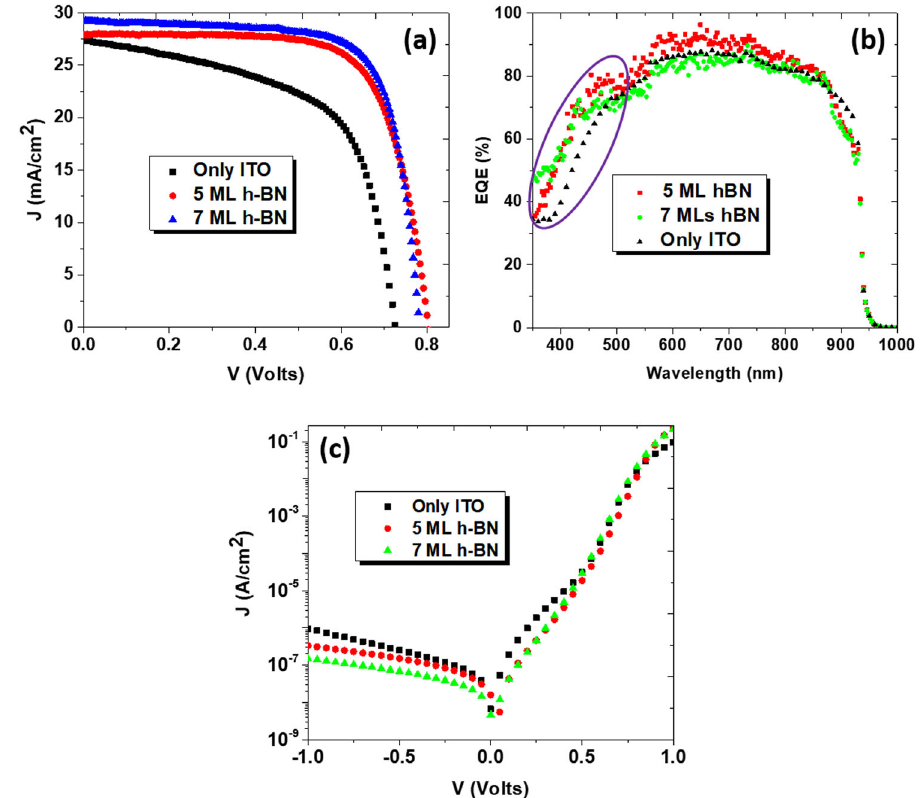
Fig. 3 IV and EQE of solar cells. Comparative a IV @ 1 sun, b EQE, and c dark IV for the solar cells with and without hBN layer.